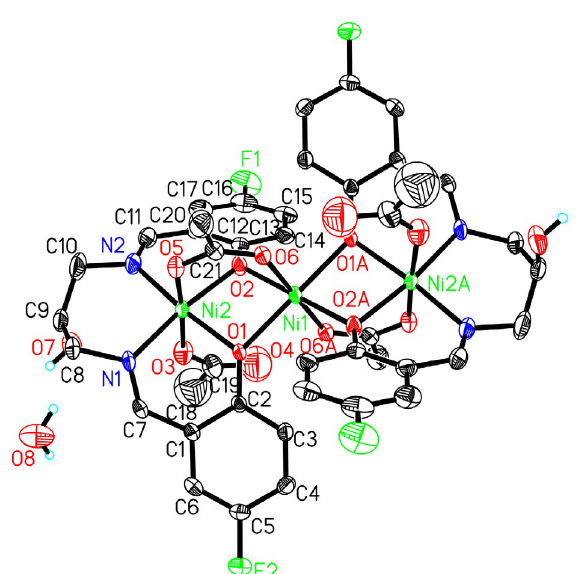
Fig. 3. Molecular structure of the nickel complex. Displacement ellip- soids are drawn at the 30% probability level and H atoms are shown as small spheres of arbitrary radii. Atoms labeled with the suffix A or unlabeled are related to the symmetry position –x, 1 – y, 1 – z.